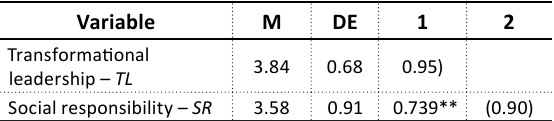
Table 2. Averages, standard deviations and correlations of study variables